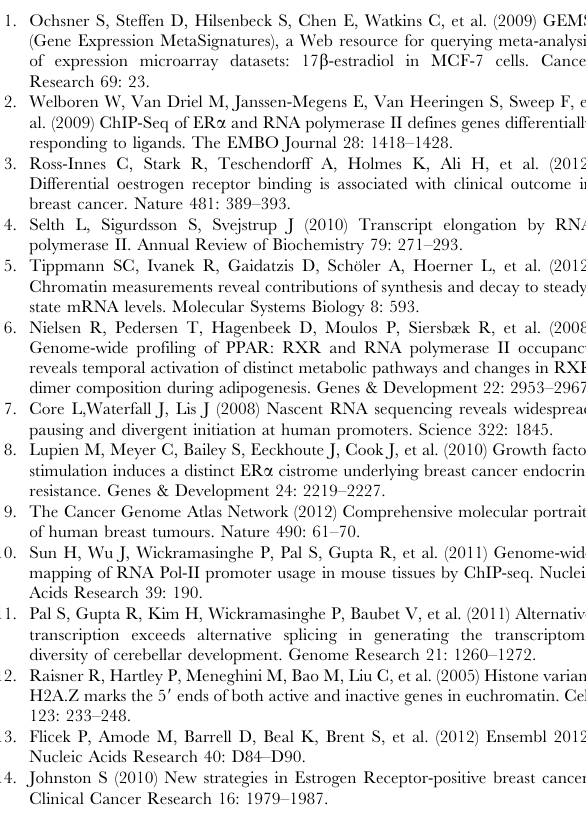
Vertical ticks represent censoring events. Log-rank probability measure for the equality of these curves is 3.618236e-02. (PDF) Figure S25 Kaplan-Meier survival plot comparing patients from [31] having above or below median expression of ATAD3B . Vertical ticks represent censoring events. Log-rank probability measure for the equality of these curves is 1.418654e-02. (PDF) Table S1 Survival-associated genes in the TCGA cohort predicted to respond to estradiol stimulus by SPINLONG. (PDF) Table S2 Gene Ontology enrichment for induced genes with an ER a binding site. (PDF) Table S3 Gene Ontology enrichment for induced genes without an ER a binding site.